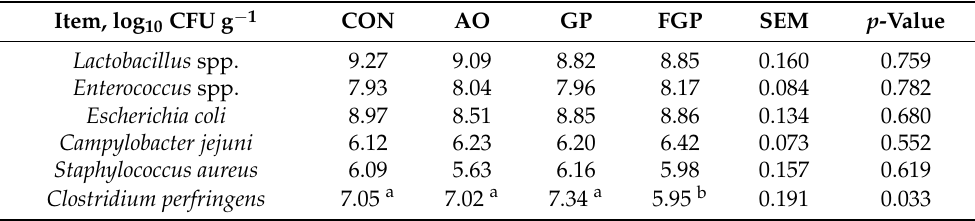
Table 6. Selected cecal bacterial species of broiler chickens fed diets containing raw grape pomace, fermented grape pomace, and synthetic antioxidants 1 .